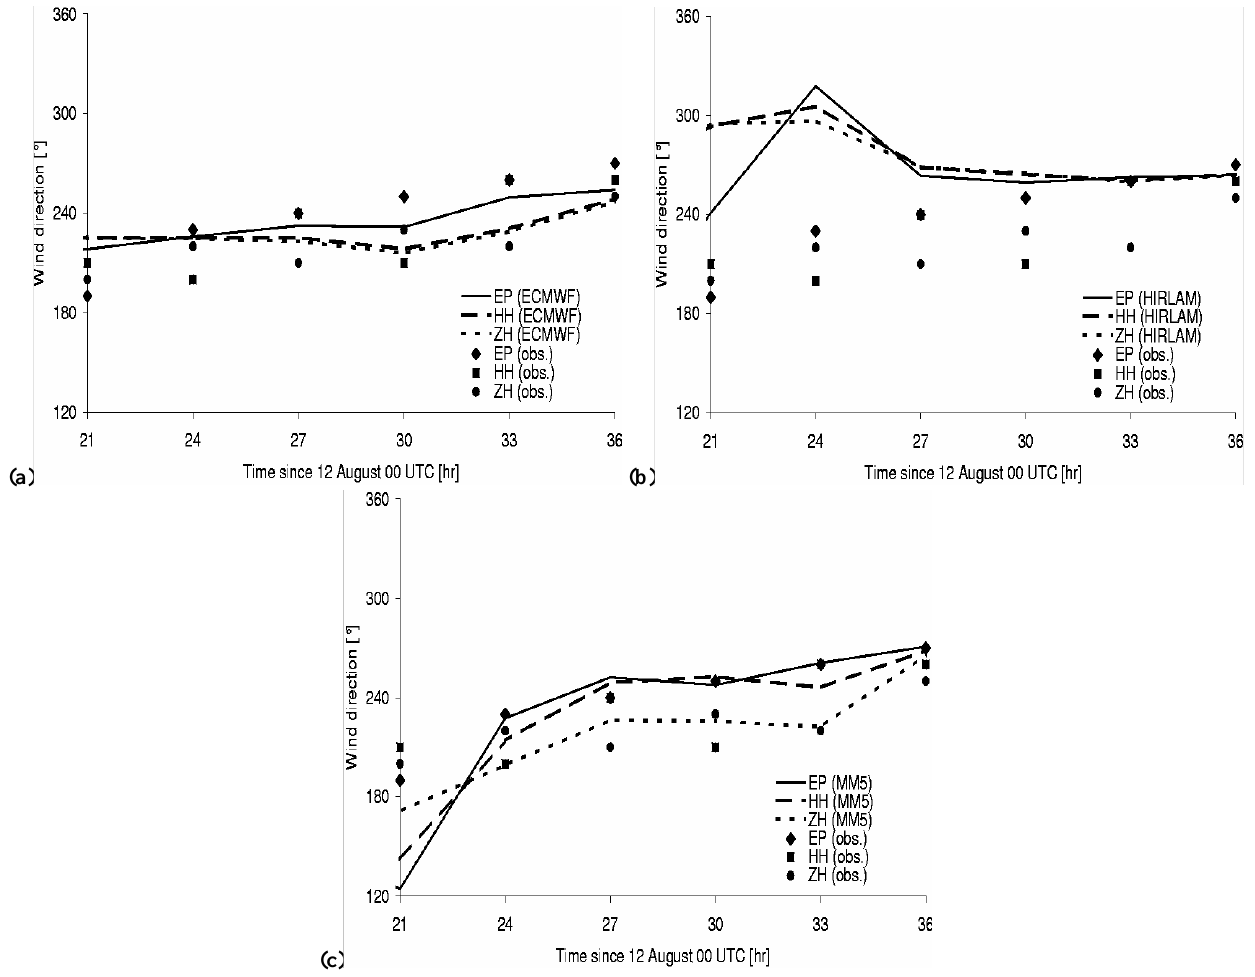
F9C Fig. 9. Time evolution of the observed wind direction ( ◦ ) for a sea station (Europlatform), a coastal station (Hoek van Holland) and an inland station (Zestienhoven) together with the model values of the closest grid points to the station. Panel (a) represents the results of ECMWF, (b) of HIRLAM and (c) of